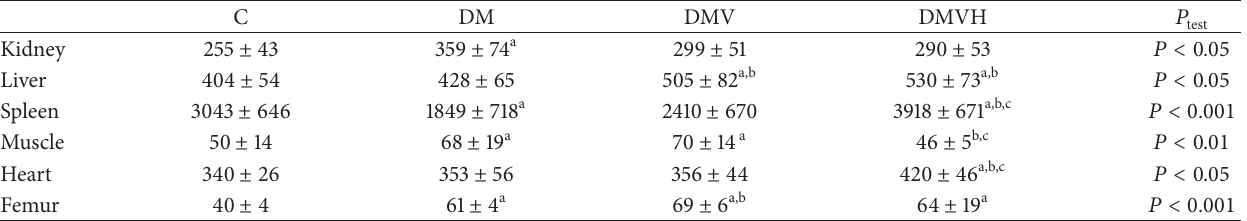
Table 2: Iron content in kidney, liver, spleen, muscle, heart, and femur (mg/kg dry tissue) on day 35. C DM DMV DMVH 𝑃